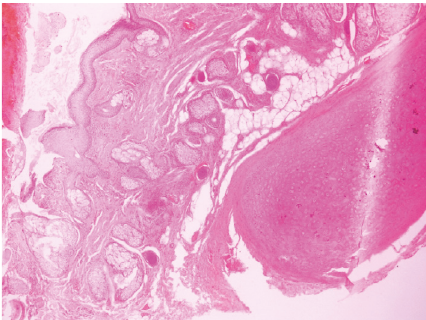
Figure 3: Wall of the cystic cavity is composed of sebaceous glands, adipose tissue, salivary gland tissue, and hyaline cartilage.